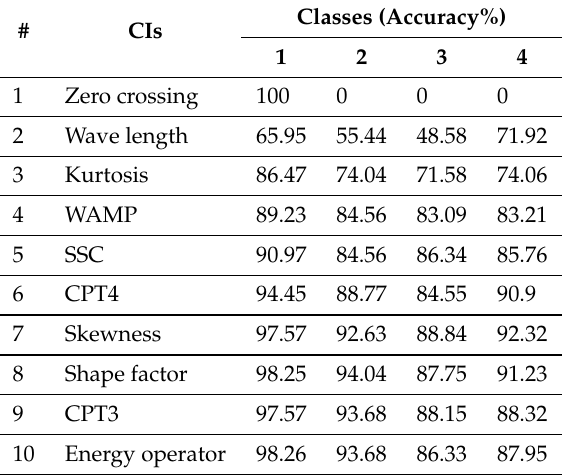
Table 4. Accuracy per class to CI_TL (time